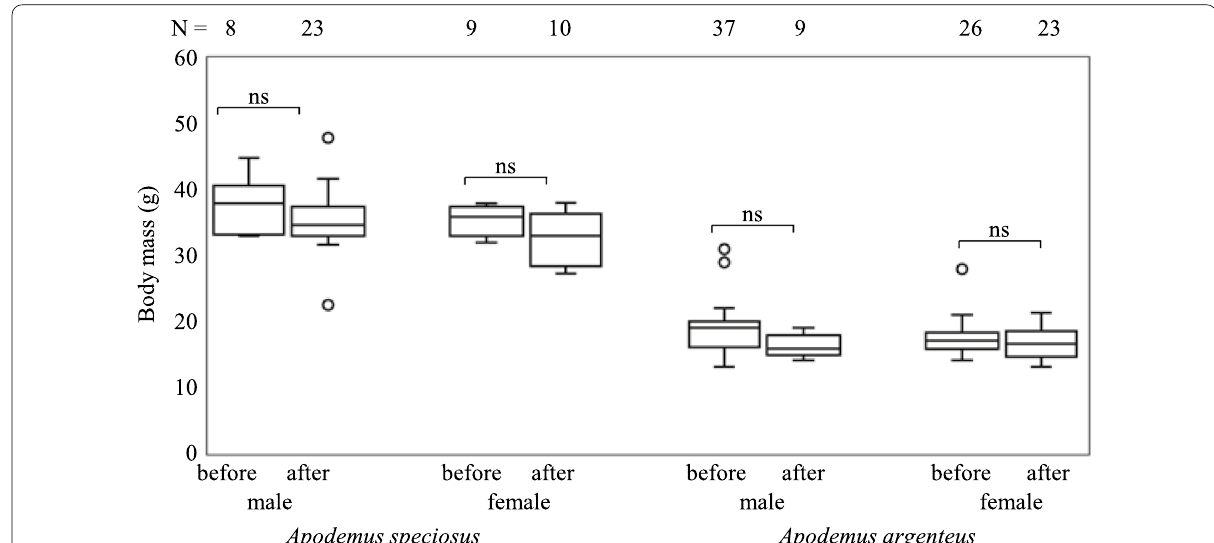
Fig. 6 Boxplots of adult body mass of the two Apodemus species individuals captured before and after the 2017 mast seeding. The numbers on the top are sample size ( n ). (Student’s T test: male A. speciosus ; T female A. argenteus ; T 0.88, p > =